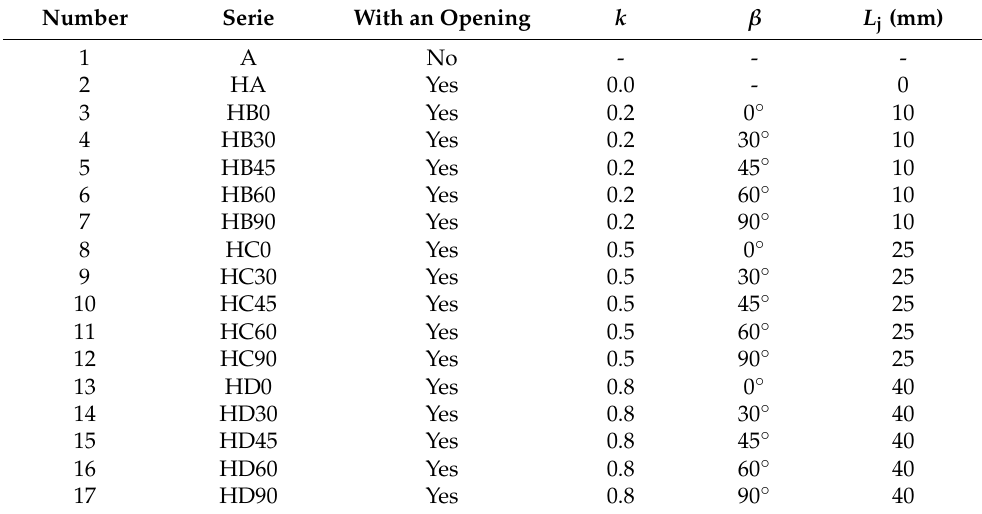
Table 1. Joint geometrical parameters of the tested specimens.